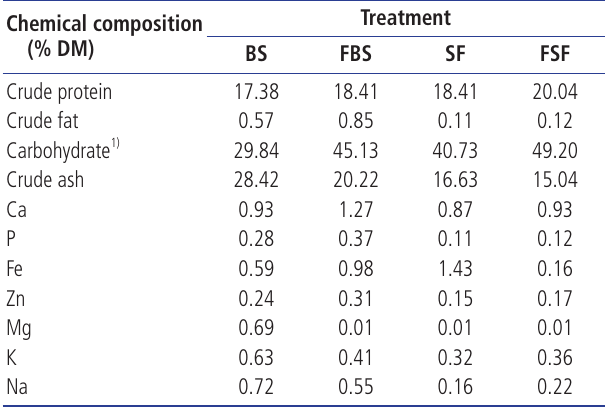
Table 1. The chemical composition in the by-products of brown seaweed, seaweed fusiforme, fermented brown seaweed and fermented seaweed